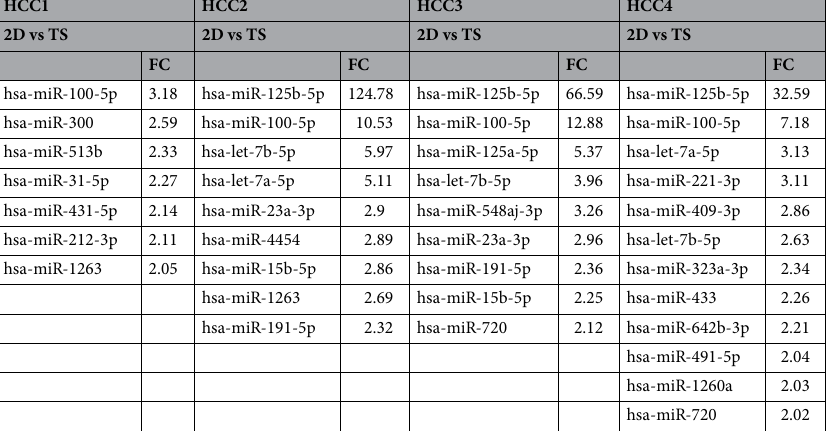
Table 1. Downregulated mRNA expression in tumorsphere (TS) cultured hepatocellular carcinoma cells derived from patient specimens. TS, tumor sphere; 2D, adherent cells; FC, fold-change.